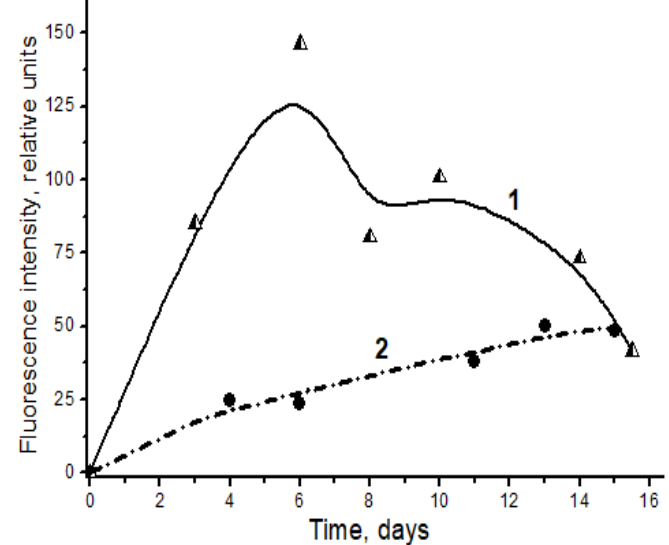
Figure 4. Spontaneous formation of fluorescent Schiff bases in the interaction of L -lysine with MDA (1, triangles) and 4-hydroxynonenal (2, circles). Changes in fluorescence intensity (excitation wavelength λ max = 350 nm) of products of L -lysine (20 mM) interaction with aldehydes (20 mM) during dark incubation at 37 °C in isotonic K,Na-phosphate buffer (pH 7.2) containing 0.02% sodium azide for prevention of bacterial growth. The figure presents mean results of three determinations; the fluorescence of a standard solution of dehydrated quinine sulfate (0.01 μg /mL in 0.05 M H 2 SO 4 ) is taken as unit of fluorescence intensity.